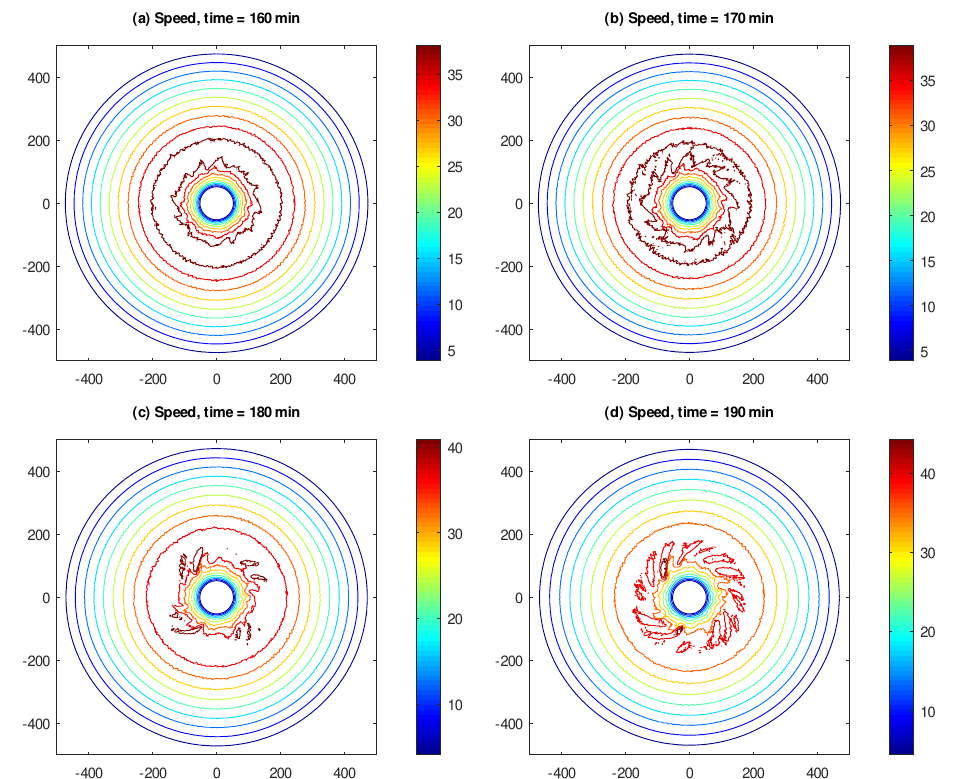
Figure 5. Speed of the cyclostrophic flow, expressed in m/s, and captured at ( a ) 160, ( b ) 170, ( c ) 180 and ( d ) 190 min of elapsed model time. The domain size is 1000 × 1000 km.